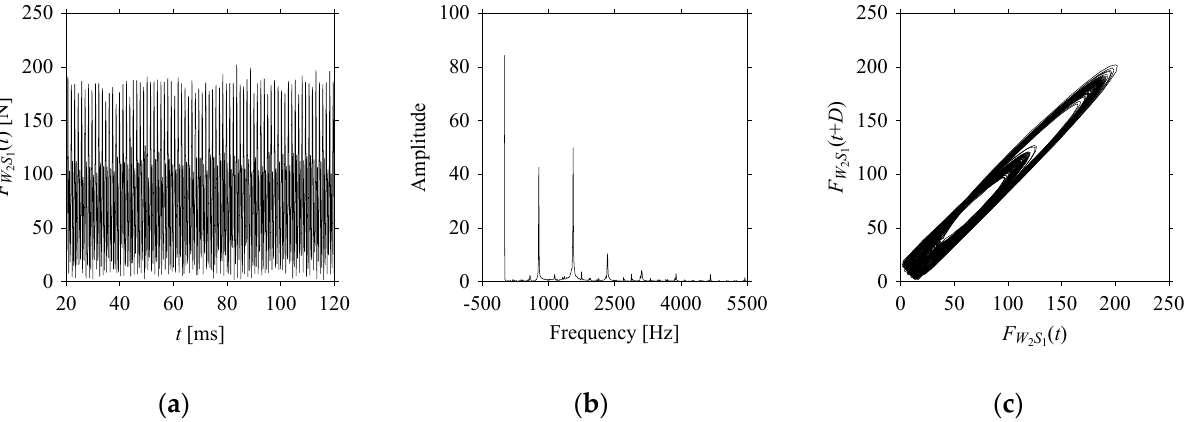
Figure A3. F W in the form of: ( a ) time series, ( b ) fast Fourier Transformation (FFT), and ( c ) delay map ( d = 1). 2